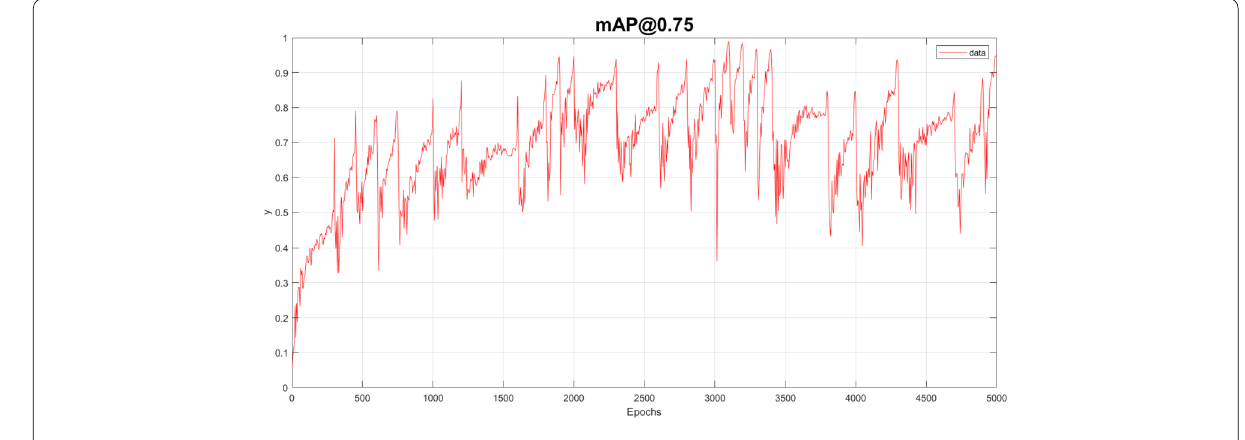
Figure 7 Change in mAP@0.75 with respect to Epochs